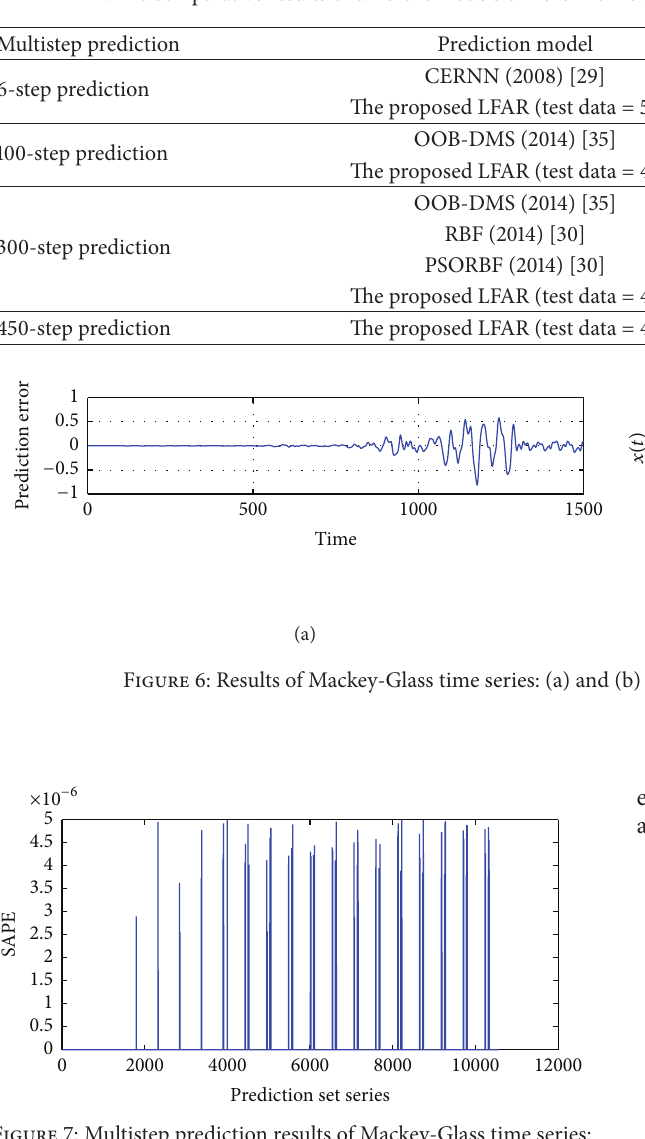
Table 1: The comparative results of different models of Lorenz time series ( (𝑟